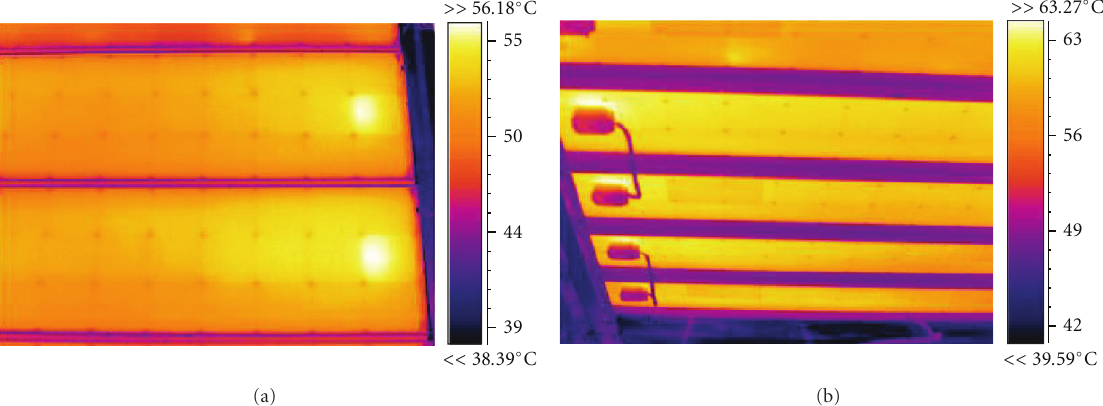
Figure 3: IR image of PV modules showing hot area at the junction box, (a) at the front of the panels, and (b) at the back of the panels.